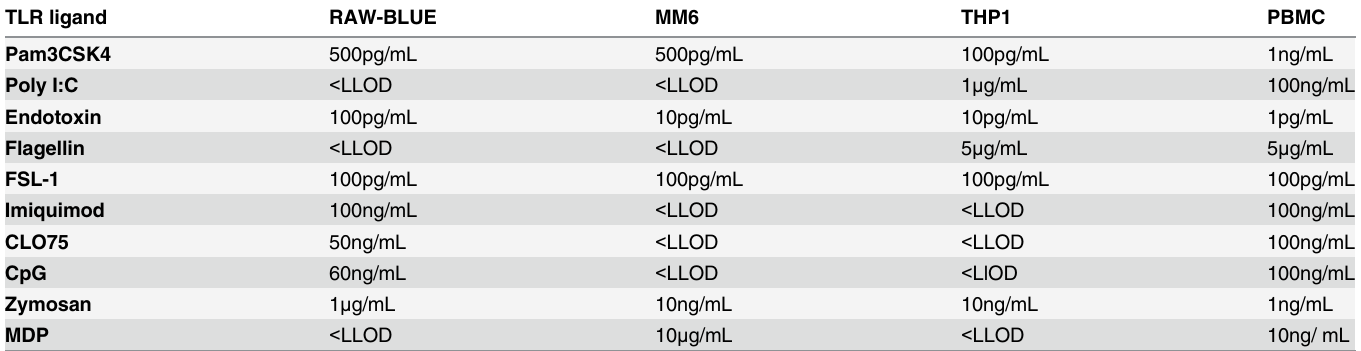
Table 2. Limit of detection for PPR ligands by monocyte/macrophage cell lines and